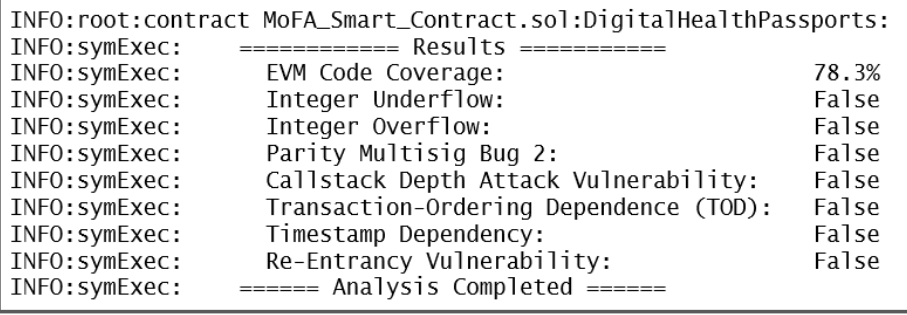
Figure 12. Vulnerability Analysis of Smart Contract using OYENTE.